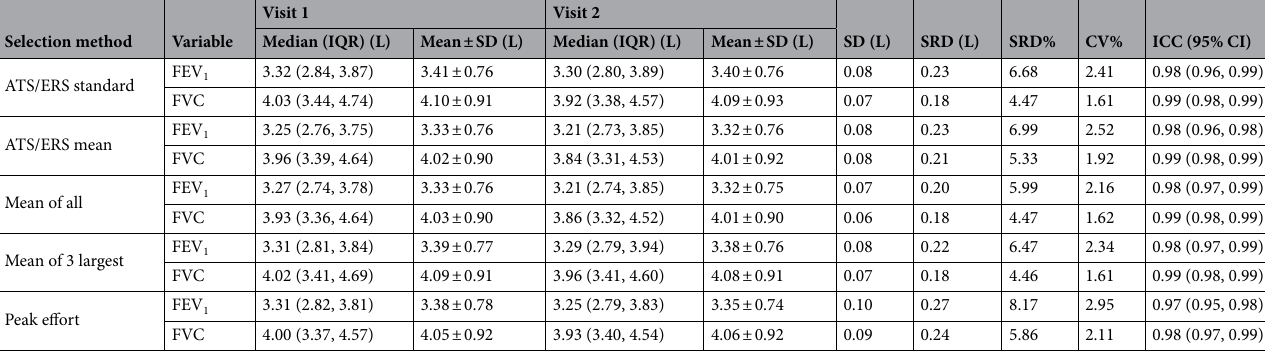
Selection method (fixed effect in fitted mixed